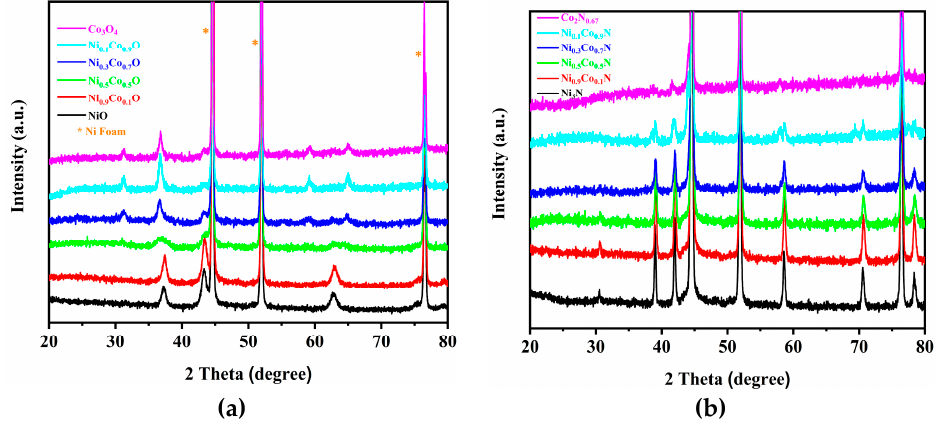
Figure 6. XRD patterns of ( a ) Ni x Co 1 − x O and ( b ) Ni x Co 1 − x N catalysts.